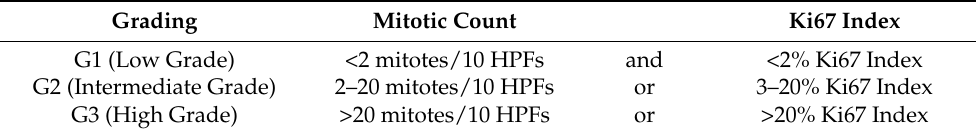
Table 1. Grading for Rectal